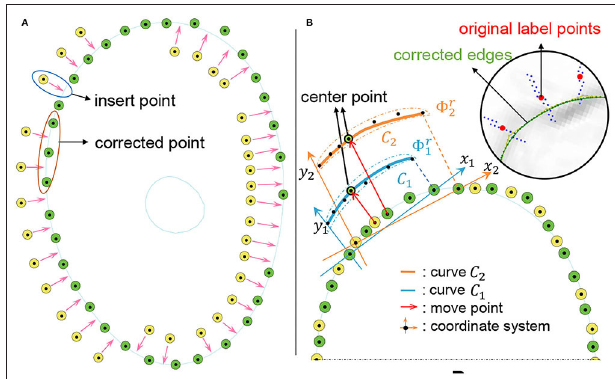
FIGURE 4 | Local point smoothing to generate smooth closed discrete edges. (A) Insert points; (B) Move the coordinate system and correct each point by curve fitting. All corrected points constitute a discrete edge.